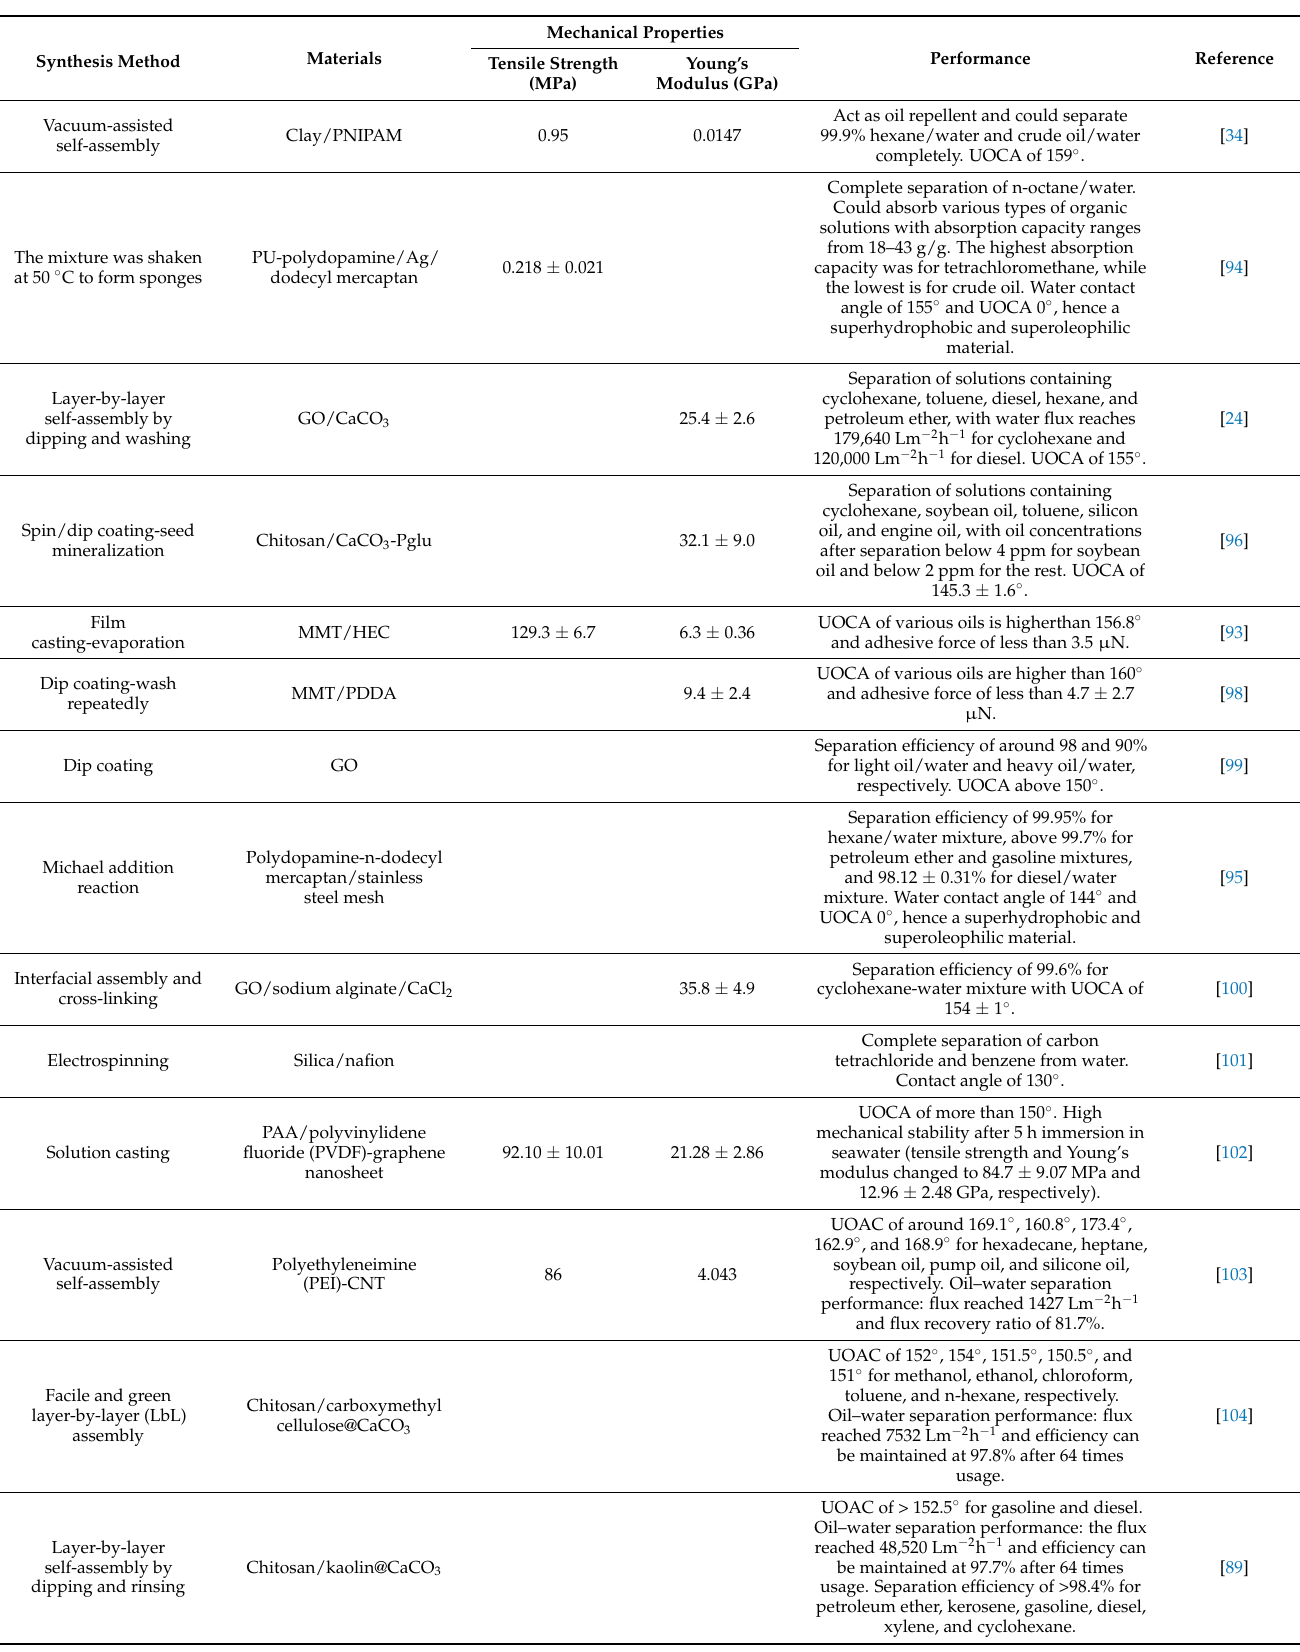
Table 2. Comparison of performance of nacre-inspired materials for oil–water